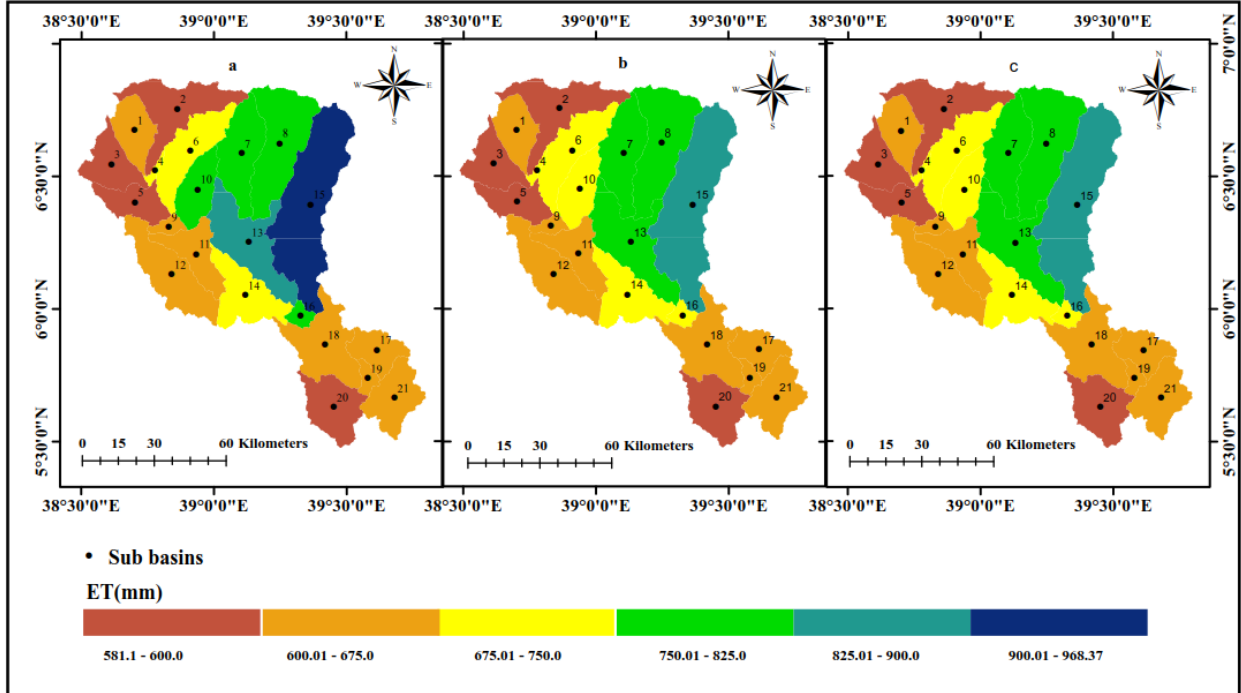
Figure 9. Simulated spatial distribution of runoff for ( a ) 1986, ( b ) 2001, and ( c ) 2016 LULC scenarios.